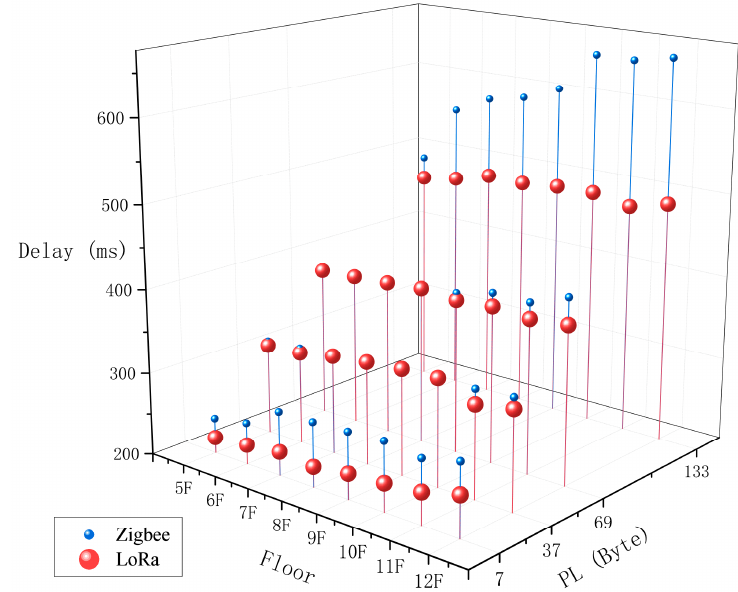
Figure 14. Test results of RTT in window position.